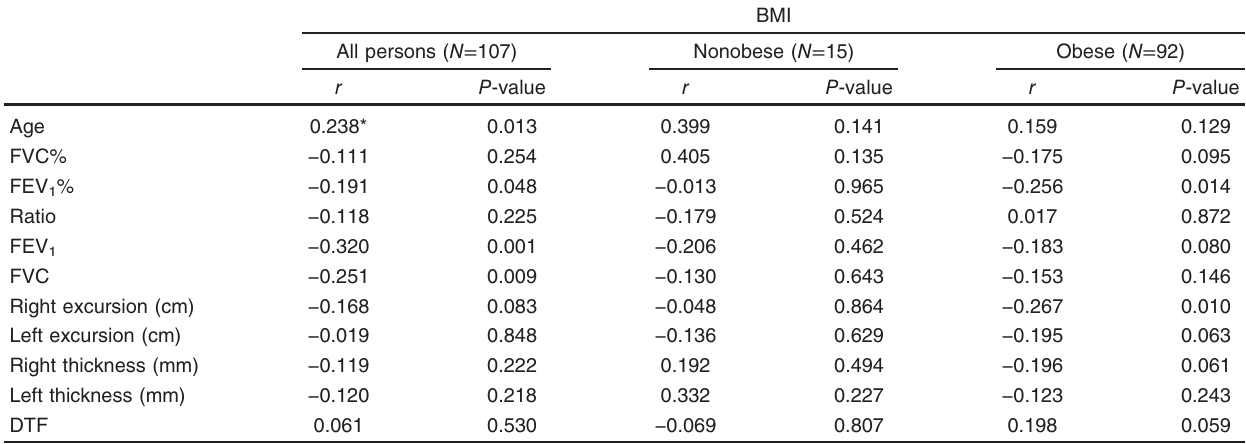
Table 3 Correlations between BMI in all, obese and nonobese persons with age, spirometric indices, ultrasonographic diaphragmatic measurements